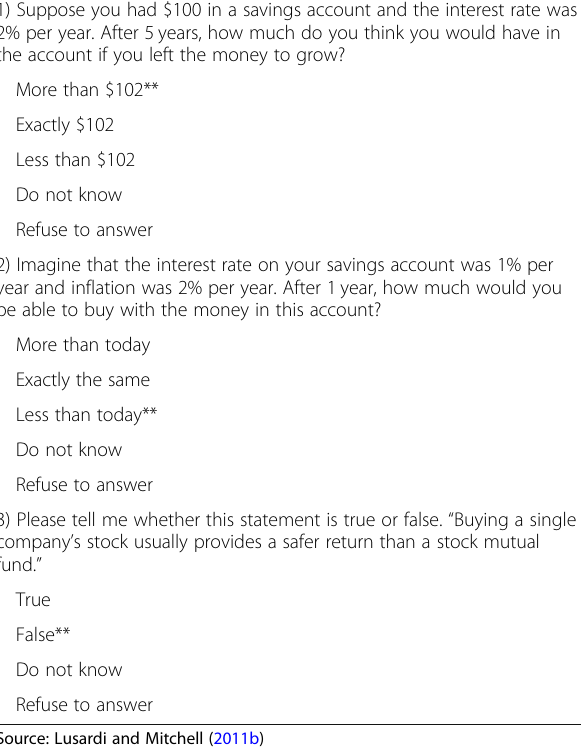
Table 1 The “ Big Three ” financial literacy